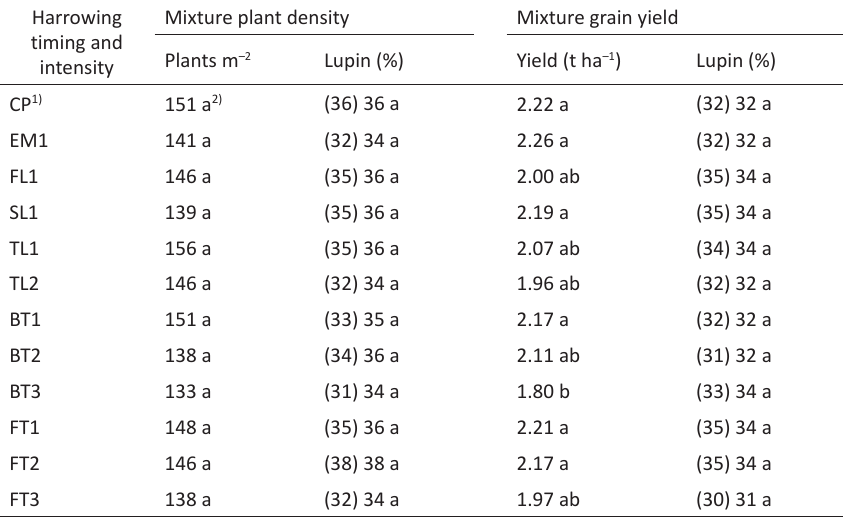
(30) 31 a 1) Letters in the first column indicate growth stages of triticale while numbers denote the number of passes with a harrow per plot; CP=non-harrowed control plots, EM=plant emergence, FL=first leaf unfolded, SL=second leaf unfolded, TL=third leaf unfolded; BT=beginning of tillering; FT=full tillering; 2) Means within column followed by a common letter are not significantly different at the 5% probability level; 3) Percentage data were arc sine transformed before ANOVA and the means are presented in the table